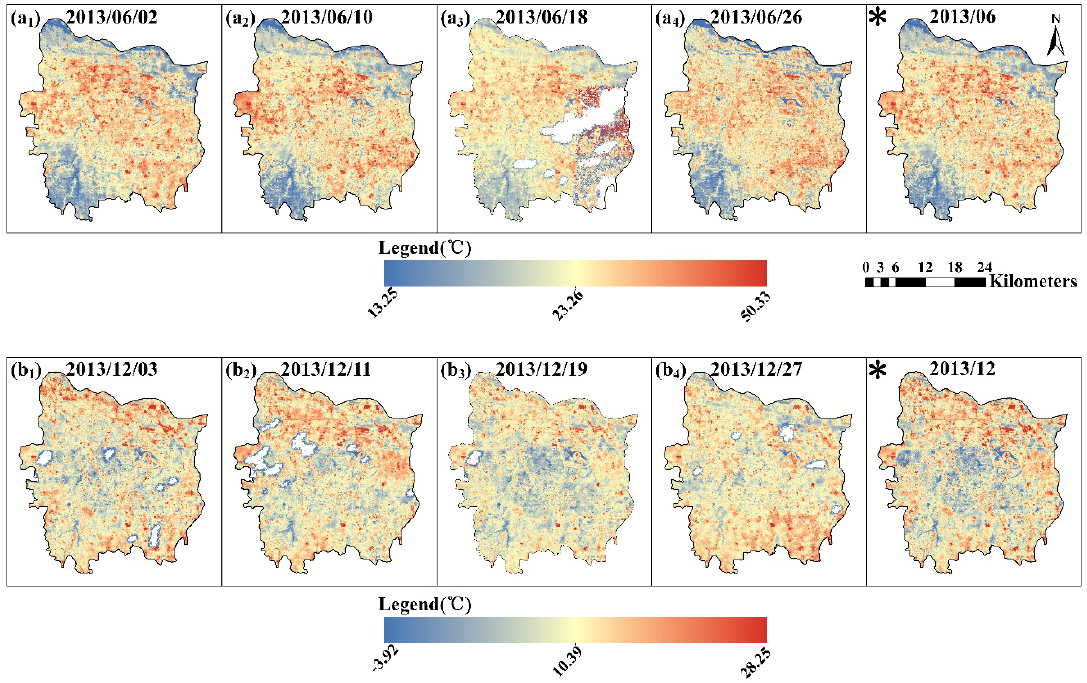
Figure 13. The monthly “Landsat-like” LST of June and December in 2013. Two rightmost ( ∗ ) represent the integrated monthly “Landsat-like” LST. (a1)–(a4) and (b1)–(b4) mean 8-day “Landsat- like” LST.